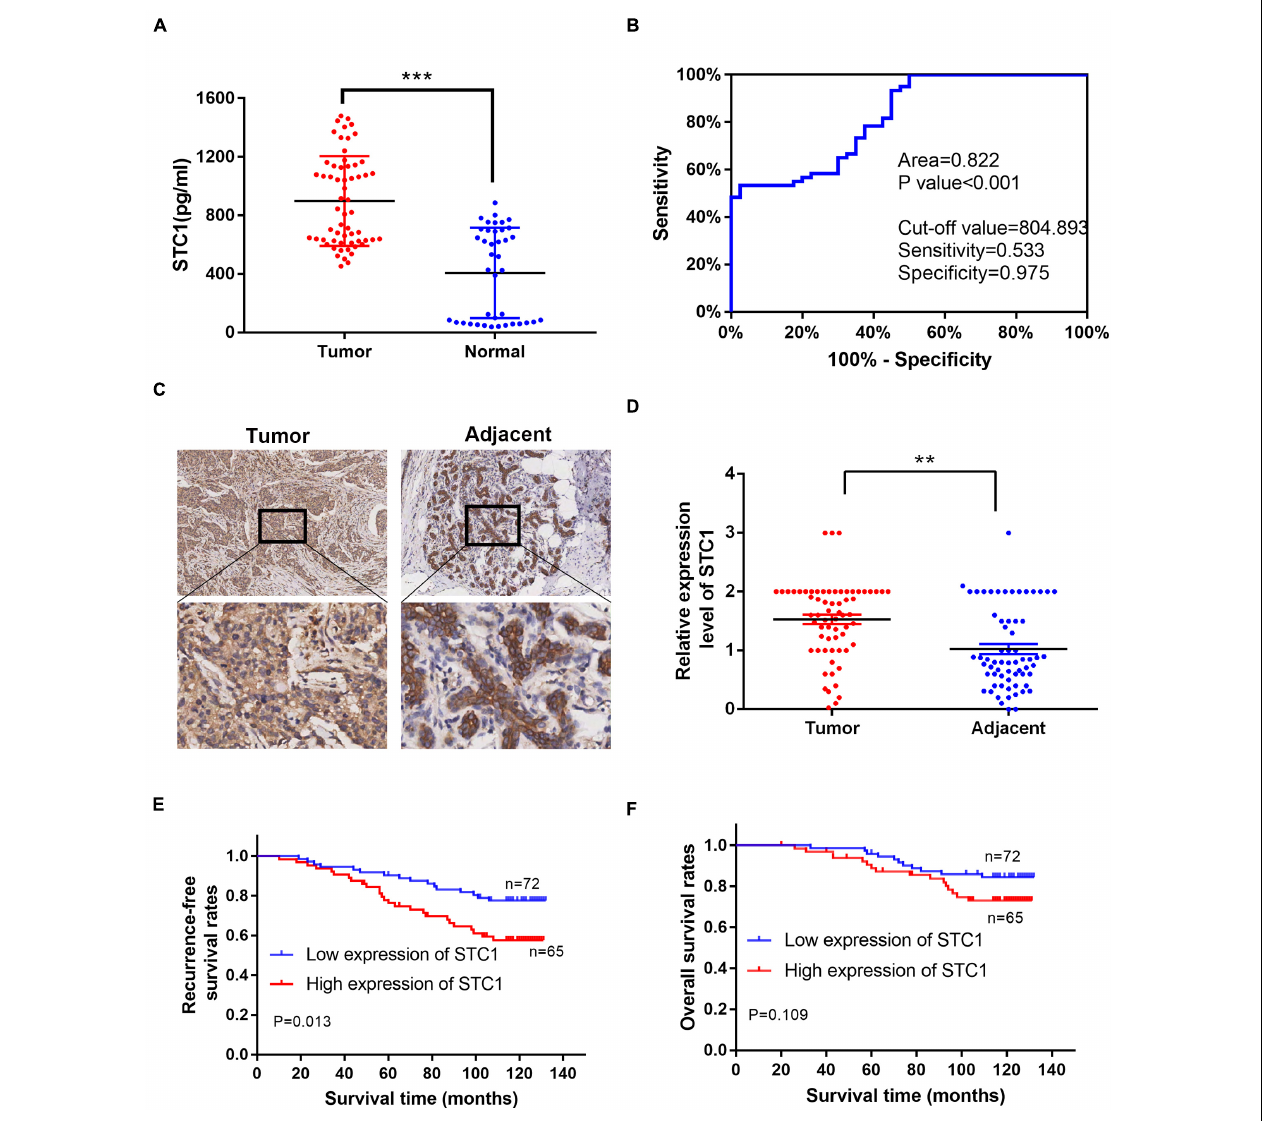
FIGURE 6 | A high expression of STC1 is associated with an advanced disease stage and poor survival in breast cancer patients. (A) The concentration of STC1 protein in the serum of 60 breast cancer patients (tumor) and 40 healthy women (normal) detected by enzyme-linked immunosorbent assay (ELISA). (B) ROC curve analysis was used to determine the value of area under the curve (AUC). (C) Representative images of immunohistochemistry (IHC) staining of STC1 on tumor tissue or the adjacent area. (D) The relative expression of STC1 level between tumor tissue and the adjacent area measured by IHC. (E,F) Recurrence-free survival (RFS) and overall survival (OS) of breast cancer patients were analyzed by the Kaplan–Meier Plotter analysis. STC1 high: n = 65; LRRK2 low: n = 72. Data are shown as mean ± SEM. P -value was determined by two-tailed unpaired t -test (** P < 0.01; *** P <